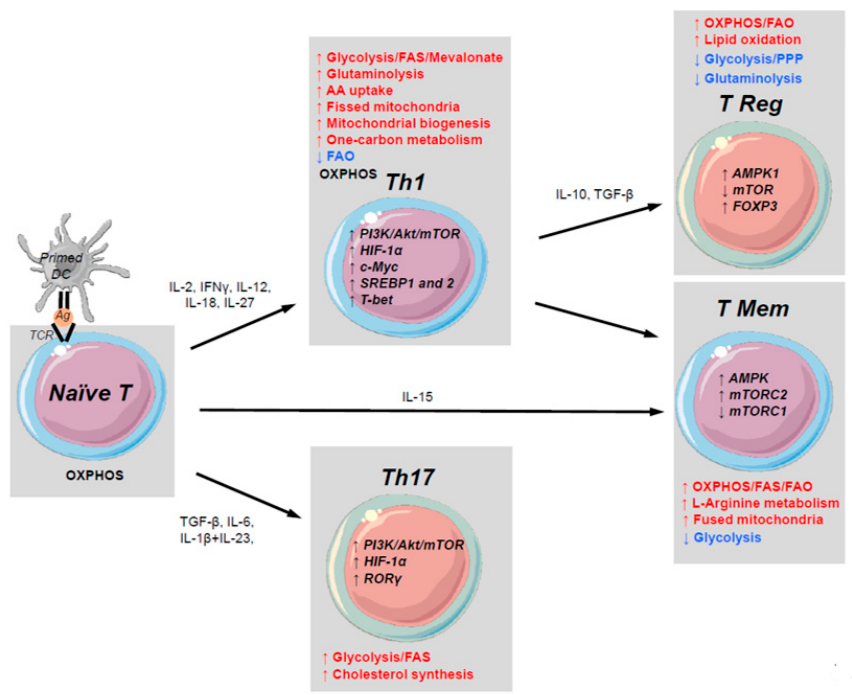
Figure 2. Metabolic rewiring following T cell activation. Metabolic requirements are indicated for the differentiation of quiescent naive T cells into Th1, Th17, TRegs, or T memory immune phenotypes. The primary metabolic pathways for each immune phenotype that are upregulated, downregulated, or unchanged are indicated in red, blue, or black respectively. The primary metabolic markers involved in these pathways within immune cells are indicated in bold black (metabolic enzymes or transcription factors). Soluble immune markers that regulate these T cell phenotypes are indicated in black (cytokines, growth factors). PI3K, phosphoinositide 3-kinase; Akt, protein kinase B; mTOR, mammalian target of rapamycin; HIF-1 α , hypoxia-inducible factor 1-alpha; AMPK, AMP-activated protein kinase; SREBP, sterol regulatory element-binding protein; T-bet, T-box expressed in T cells; FAS, fatty-acid synthesis; AA, amino acids; FAO, fatty-acid oxidation; ROR γ , RAR-related orphan receptor gamma; FOXP3, forkhead box P3; PPP, pentose phosphate pathway; TCR, T cell receptor; Ag, antigen.